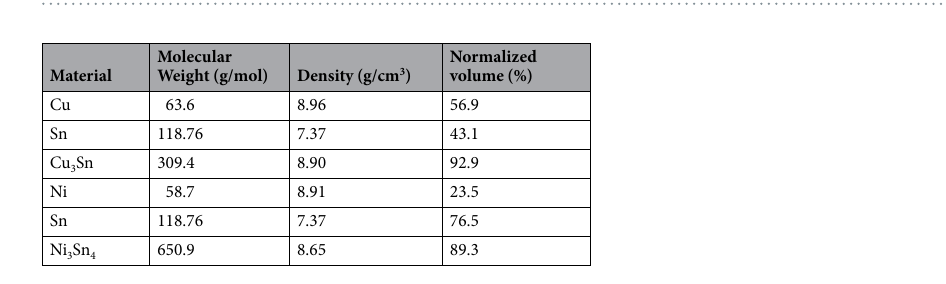
Figure 5. ( a ) The SEM image of the dummy 120- µ m FC solder joints suffered from the same thermal history as the current-stressed joints. The SEM image showing the microstructure for the joint stressed by ( b ) an upward and ( c ) a downward electron flow for 1087 h.